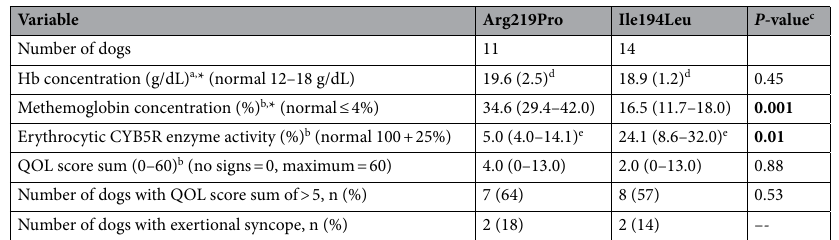
Table 2. Comparative laboratory test results and total quality of life scores for dogs with hereditary methemoglobinemia associated with homozygous Arg219Pro or Ile194Leu missense CYB5R3 gene variants. Purebred comparisons can be found in Supplemental Table S4. Hb hemoglobin, CYB5R cytochrome b 5 reductase, n number, QOL quality of life. *Significant difference of both variants to simultaneously sent unaffected controls. a Data presented as mean (standard deviation). b Data presented as median (interquartile range). c Significant P -values bolded. d Hemoglobin concentration available in Arg219Pro homozygous dogs (n = 9) and Ile194Leu homozygous dogs (n = 10). e Erythrocytic CYB5R enzyme activity available in Arg219Pro (n = 9) and Ile194Leu (n =